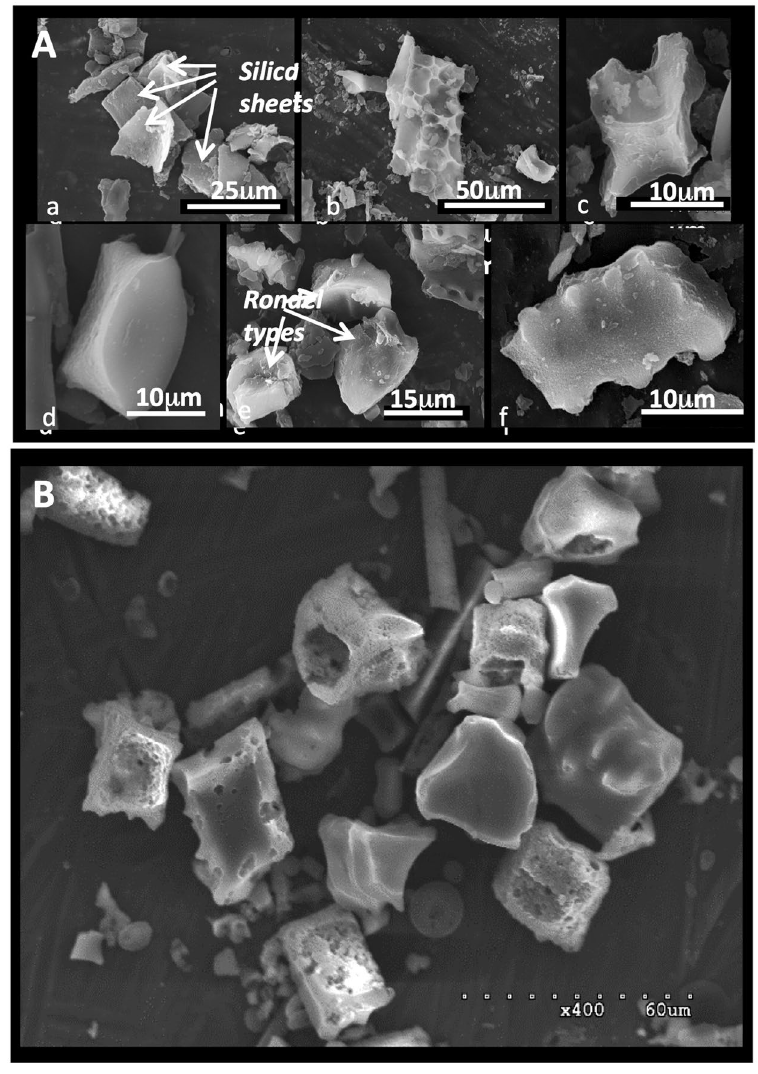
Figure 1. From Alexandre et al . Biogeosciences (2015) (ref. 18.) SEM images of ( A ) TD-F-L wheat phytolith assemblage. Three categories are illustrated: (1) silica sheets (a,b), (2) stellate type from intercellular space (c) and (3) GSC phytoliths including rondel (d,e) and polylobate types (f); and ( B ) MSG70 weathered soil phytoliths. The particles show enlarged internal cavities typical of weathered